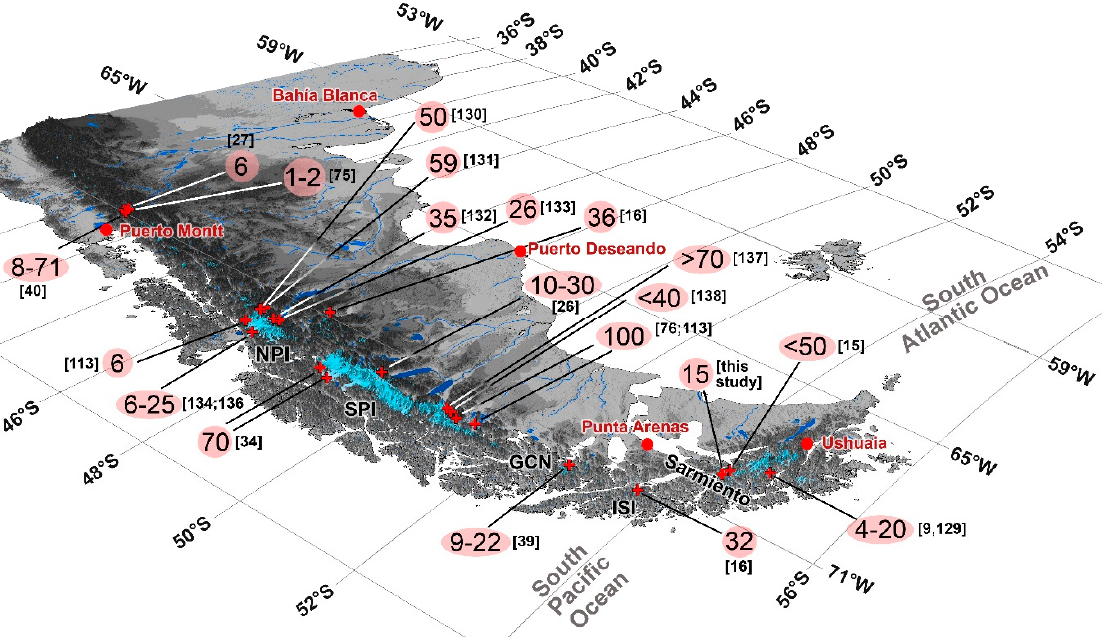
Figure 9. Overview of different ecesis intervals for trees colonizing recently exposed glacial deposits in the Patagonian Andes. Numbers highlighted in red represent the intervals; numbers in square brackets represent the respective reference study (NPI, SPI: Northern and Southern Patagonian Icefield; GCN: Gran Campo Nevado; ISI: Santa Inés Island). [9,15,16,26,27,34,40,75,76,117,129–139]